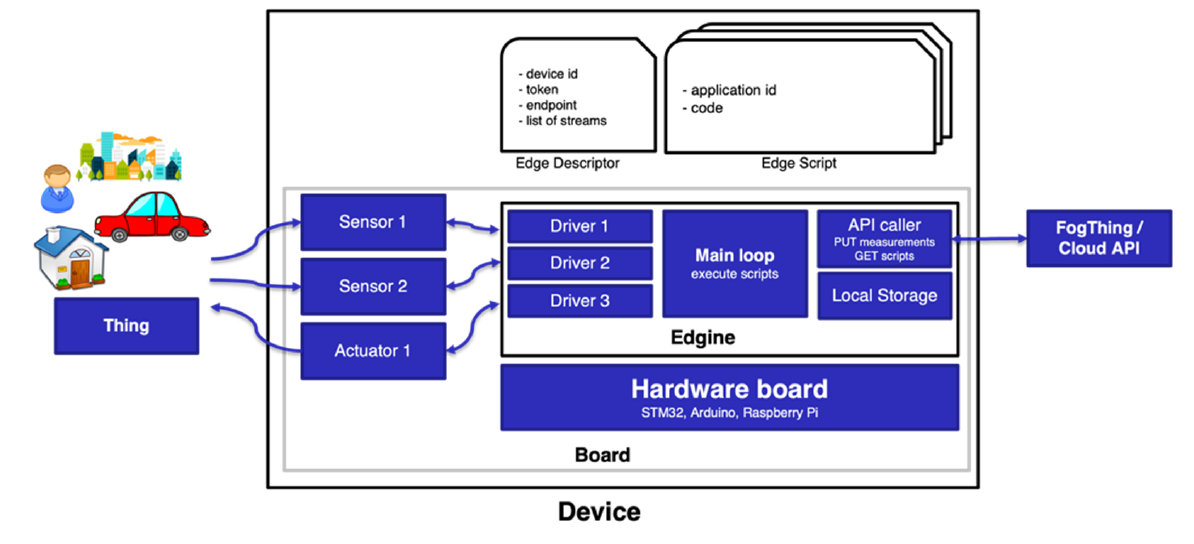
Figure 2. Block diagram of a field device.